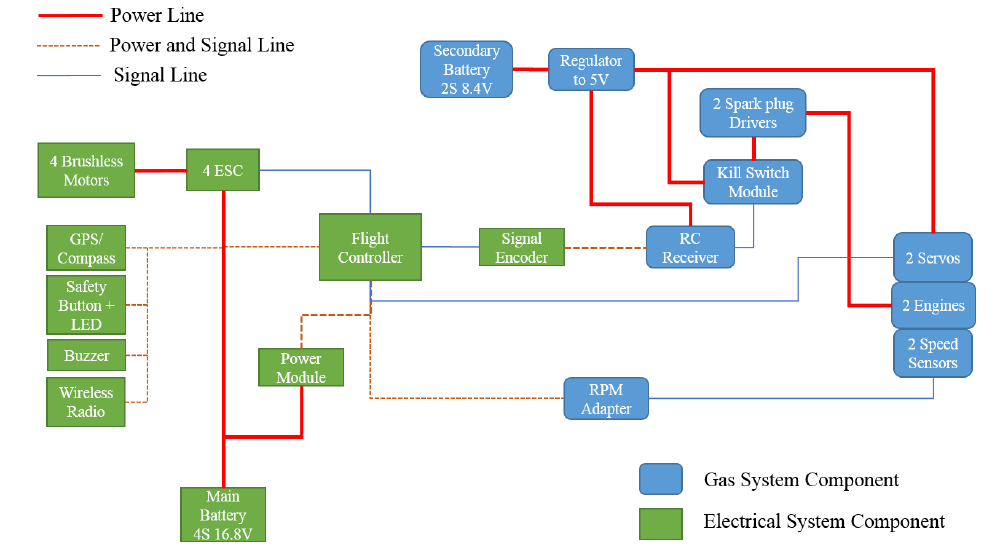
Figure 3. Electrical diagram showing the connections between the electric and gas system